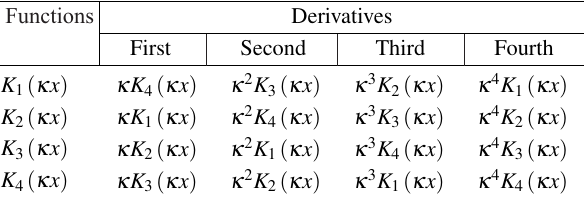
Table 1. A cyclic order of Krylov-Duncan functions derivatives